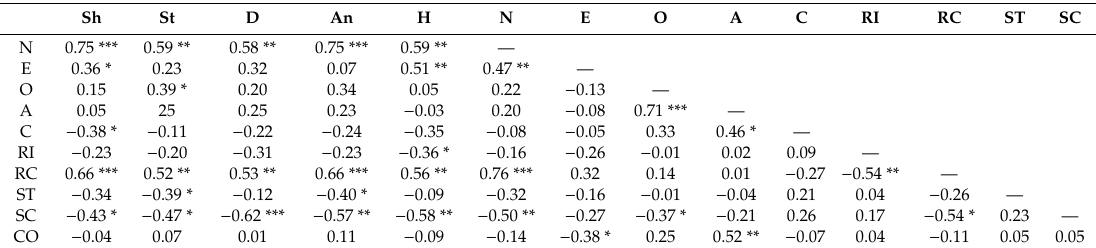
Table 4. Correlations between religious struggle, self and other compassion, personality, and mental health